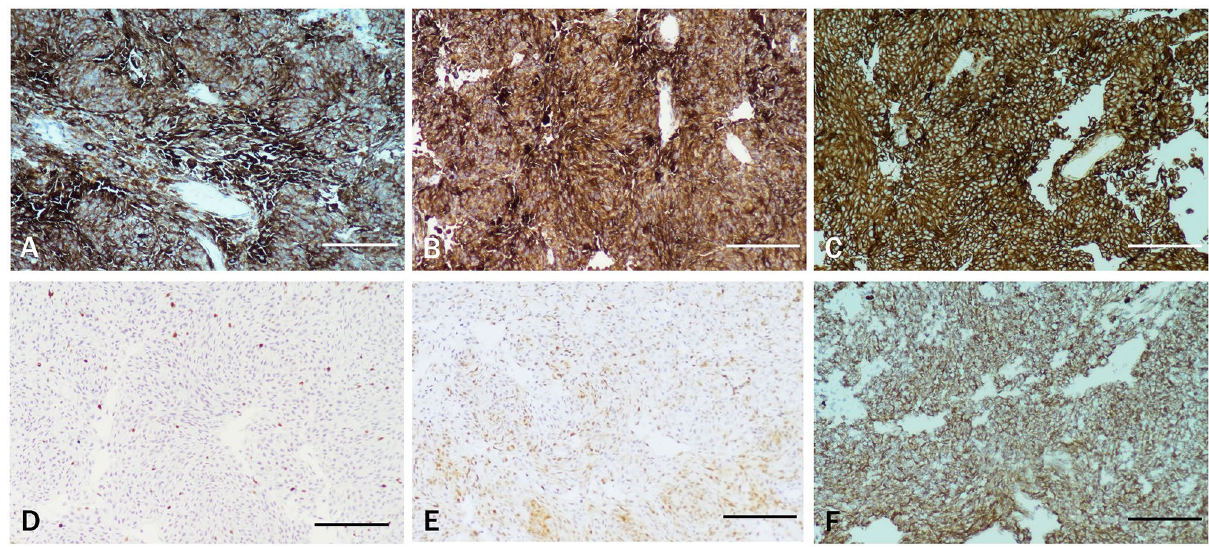
Figure 5. Immunohistochemical staining was performed on meningeal melanoma tissue. ( A,D ) were stained with ki67; ( B,E ) were stained with S100; ( C,F ) were stained with β-catenin. ( D–F ) were treated with 8% TCCA. Scale bar means 100 μm.